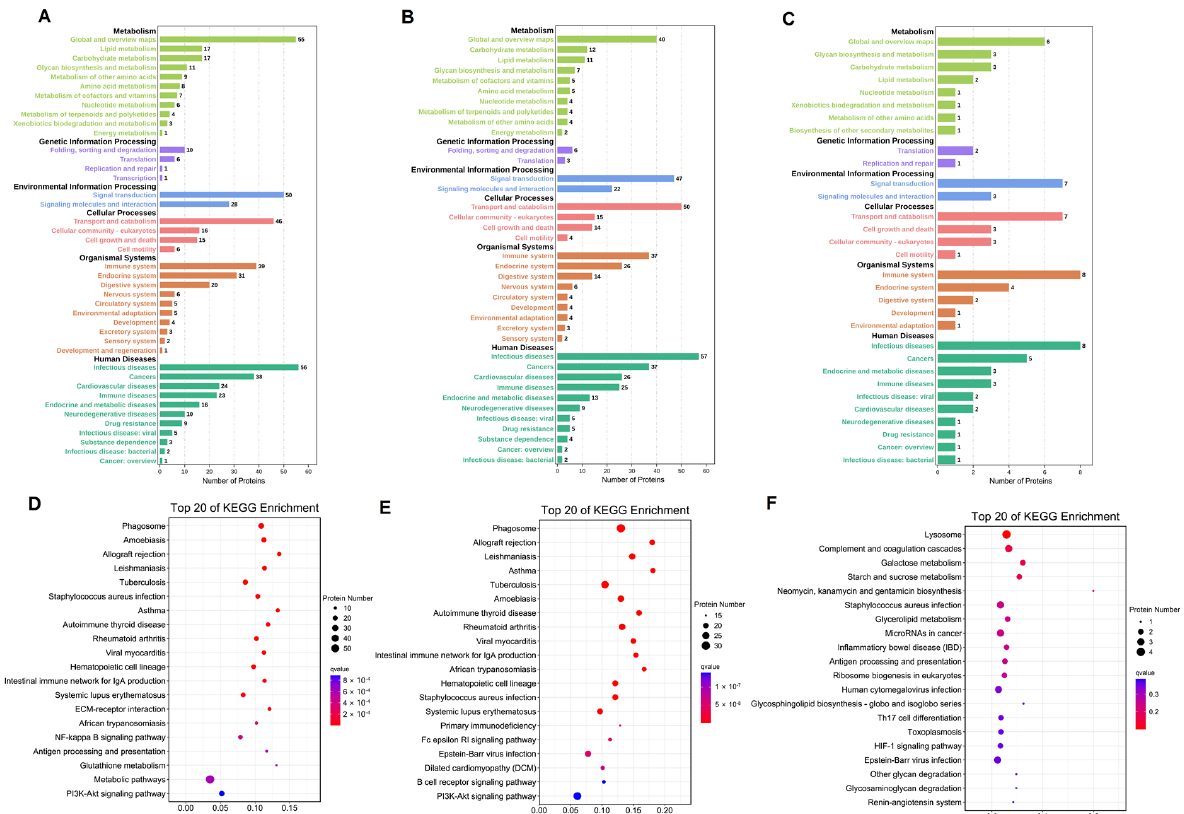
Figure 5. Analysis of differentially expressed proteins in C vs. M ( A ), C vs. T ( B ), and M vs. T ( C ) in KEGG pathway. Top 20 of KEGG enrichment pathway in C vs. M ( D ), C vs. T ( E ), and M vs. T ( F ). The size of the dot represents the number of differential proteins annotated to the pathway. The color of the dot represents the size of the P value.